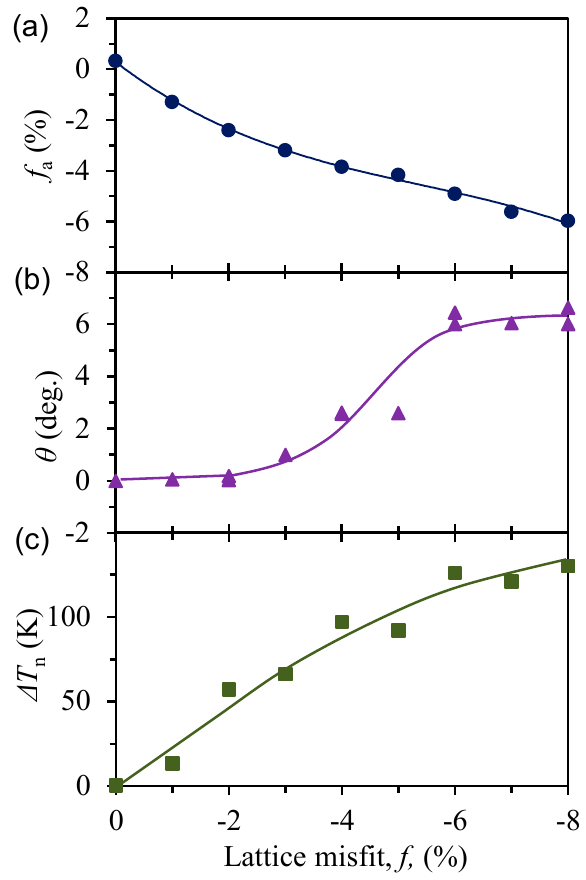
Figure 8. ( a ) Accommodated lattice misfit, f a , in L1, ( b ) the twisted angle, θ , of the solid relative to the substrate, and ( c ) nucleation undercooling, Δ T n , as a function of the initial lattice misfit, f . The nucleation undercooling, Δ T n , is the difference between the liquidus ( T l ) and the nucleation temperature ( T n ): Δ T n = T l − T n . In this work, we take Δ T n = 0 K for the system with f = 0% as the reference point and then Δ T n for systems with varying f can be determined. The calculated Δ T n as a function of misfit is plotted in Figure 8c, which shows that nucleation undercooling increases with increasing misfit (0 ≤ | f | ≤ − 8%).